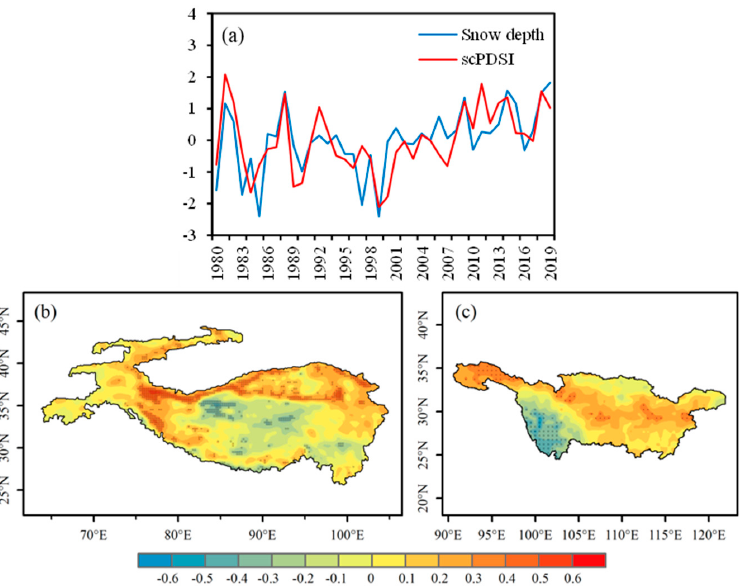
Figure 9. The spatial distributions of the left and right fields of the second SVD mode and their time series, derived from winter snow depth of HMA and the succeeding summer scPDSI of YRB during the period 1980–2019. ( a ) Normalized time series of winter snow depth (blue line) and summer scPDSI (red line)—units are arbitrary; ( b ) snow depth of HMA and ( c ) scPDSI of YRB—dotted area means passing significance test of 0.05.